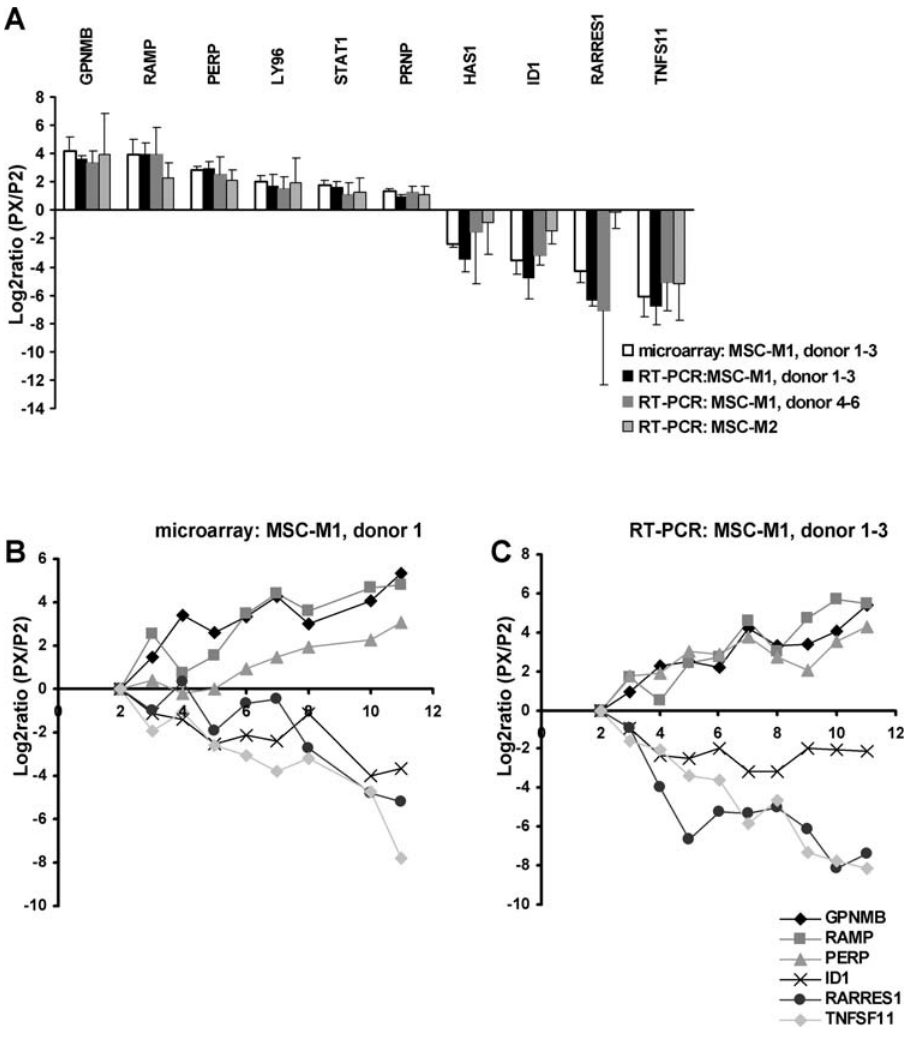
Figure 5. QRT-PCR validation of mRNA expression. Differential expression of senescent passage (PX) versus P2 was validated by using QRT-PCR for 10 genes (A). Results were in line with microarray data for all tested genes, investigating either the same three MSC preparations (donor 1–3) or three independent donor samples that were isolated in the same culture medium M1 (donor 4–6). Furthermore, differential gene expression was also observed in three MSC preparations isolated under different culture conditions (M2). Differential mRNA expression was not restricted to senescent passages but increased during the course of replicative senescence (B,C).